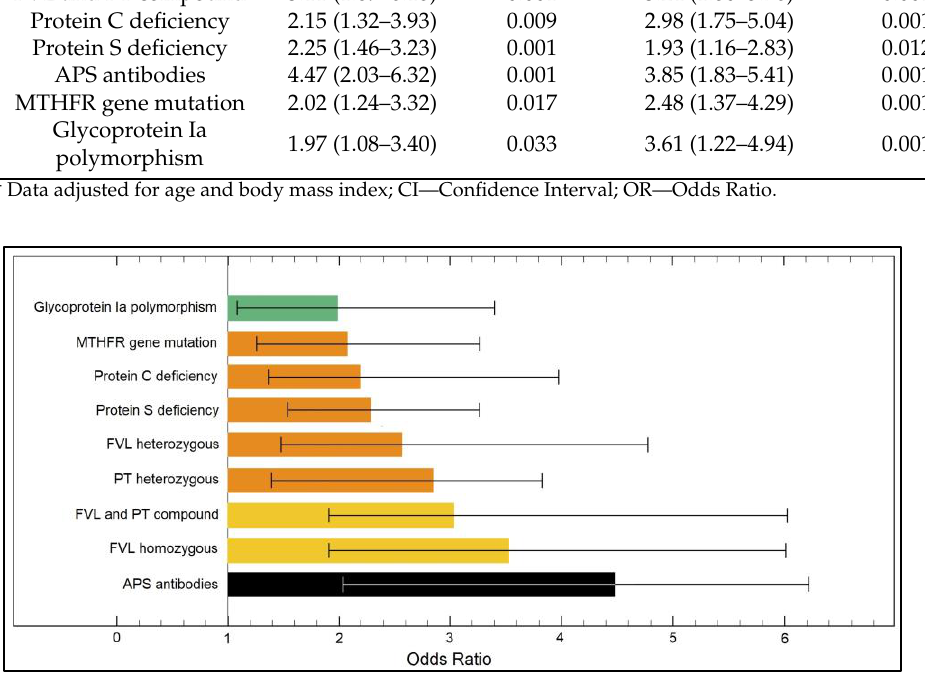
Figure 2. Risk factor analysis for early (first trimester) pregnancy loss.